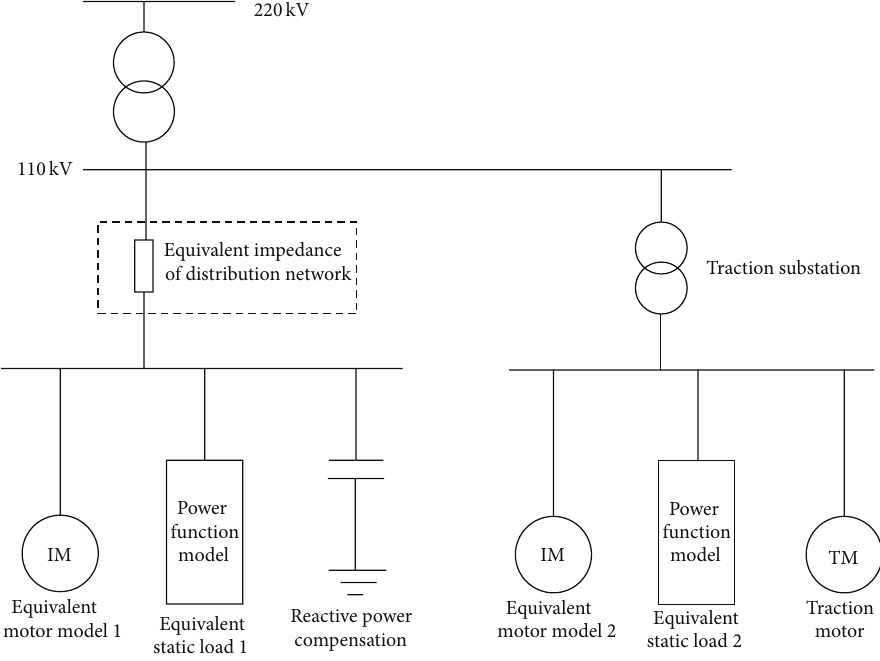
Figure 3: The structure diagram of DTSLM.